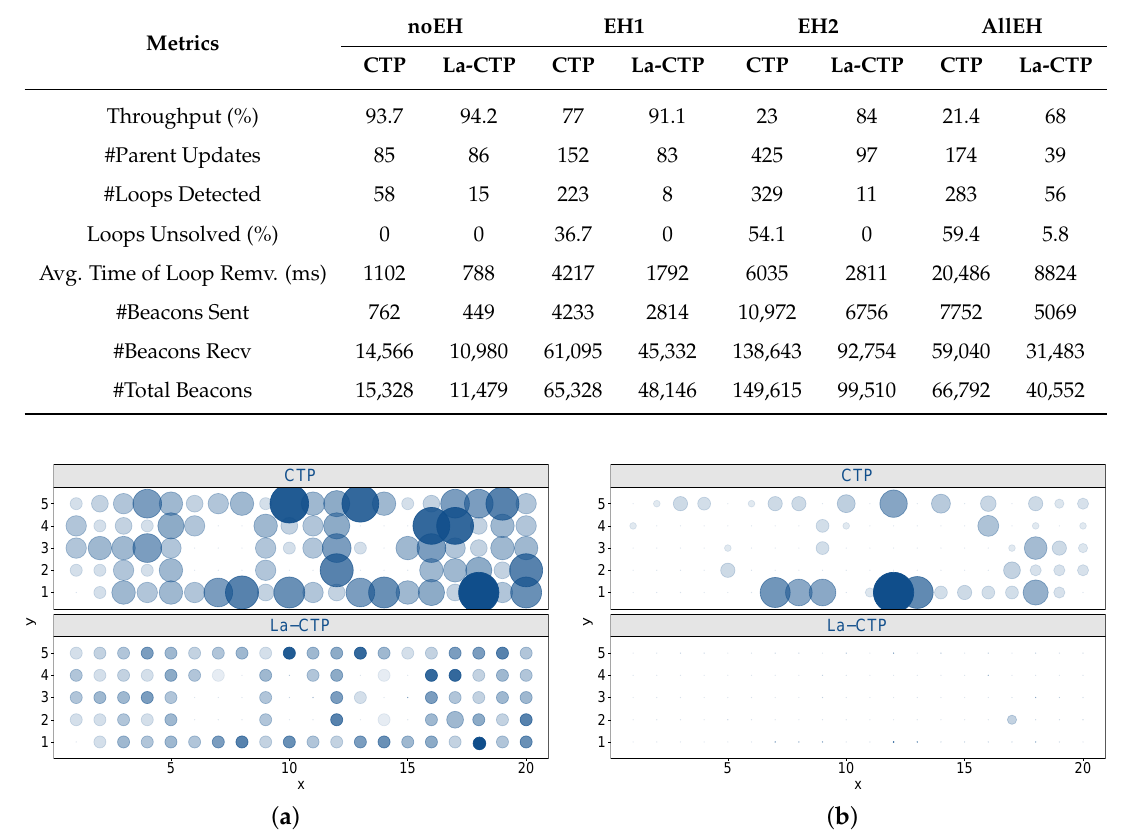
Table 1. Comprehensive performance comparison of two protocols under three scenarios.